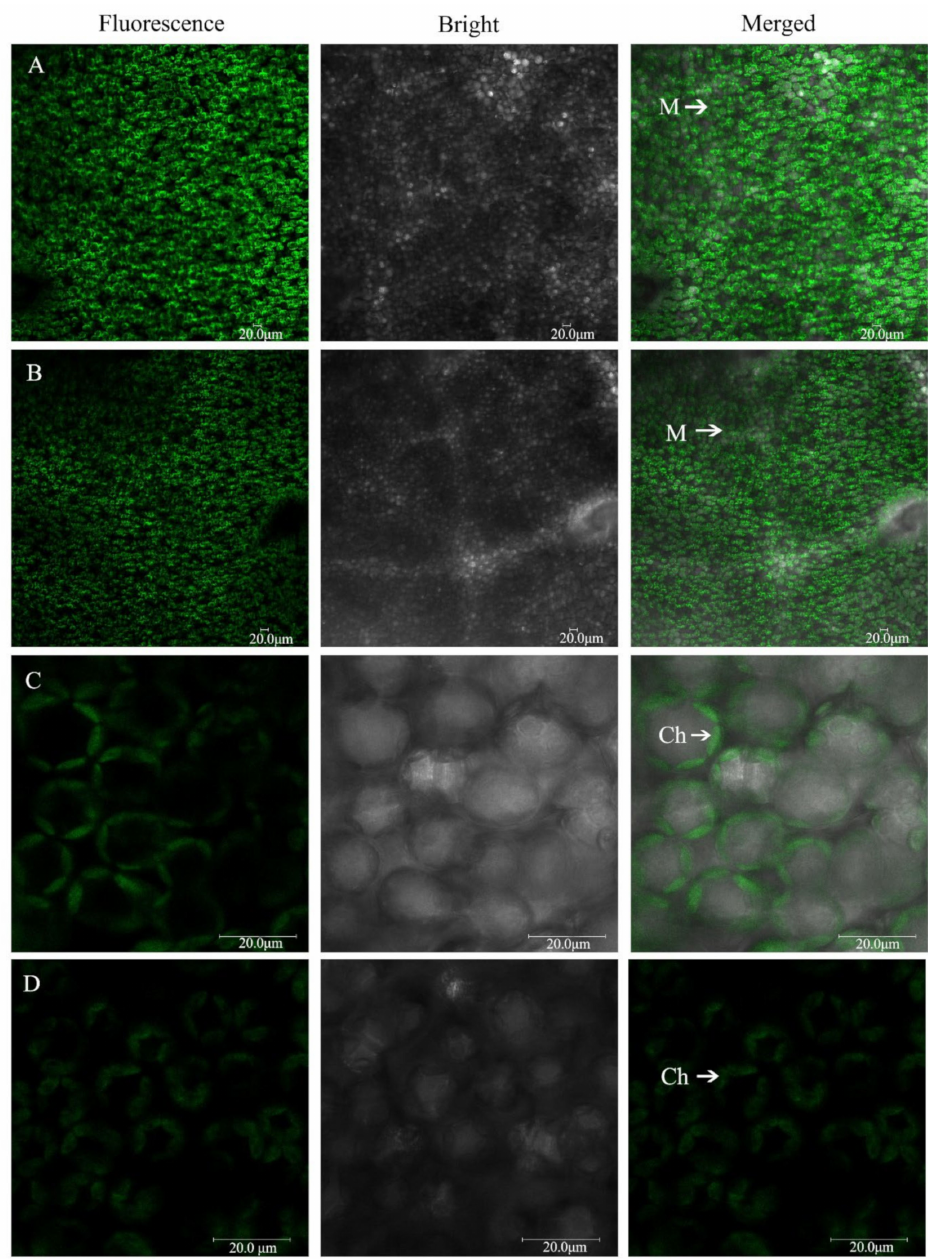
Figure 5. The morphology of the mesophyll cells ( A ): P 0.25 ; ( B ): P 0.001 and chloroplasts; ( C ): P 0.25 ; ( D ): P 0.001 imaged by confocal laser-scanning microscopy under the different Pi treatments. M: mesophyll cell; Ch: chloroplast. Scale bars, 20 µ